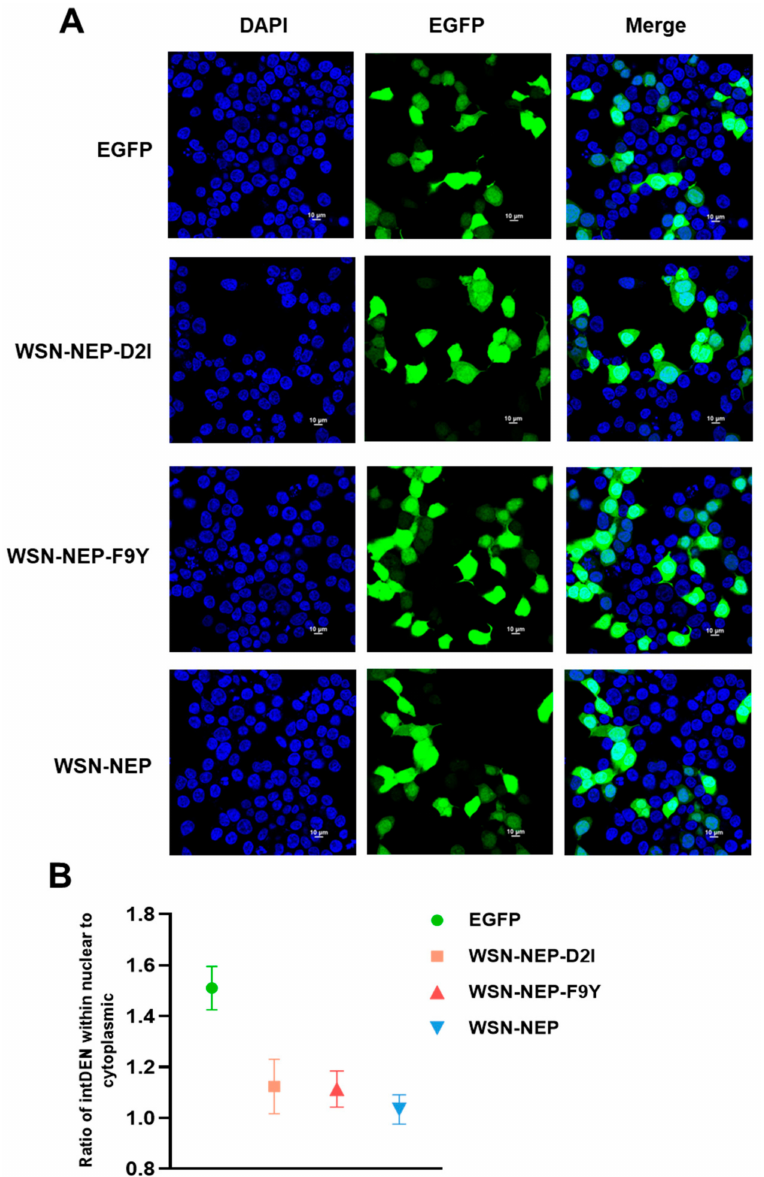
Figure 8. Identification of the WSN-NEP and NEP mutants mediating the nuclear export of eGFP fusion protein. ( A ) HEK293T cells growing on cover glass were transfected with pCAGGS encoding eGFP-NEP, eGFP-NEP D2I mutant or eGFP-NEP F9Y mutant. Cells were stained with the 4, 6- diamidino-2-phenylindole (DAPI) and were examined via confocal microscopy 24 h post-transfection. ( B ) Quantification of fluorescence signal was performed by